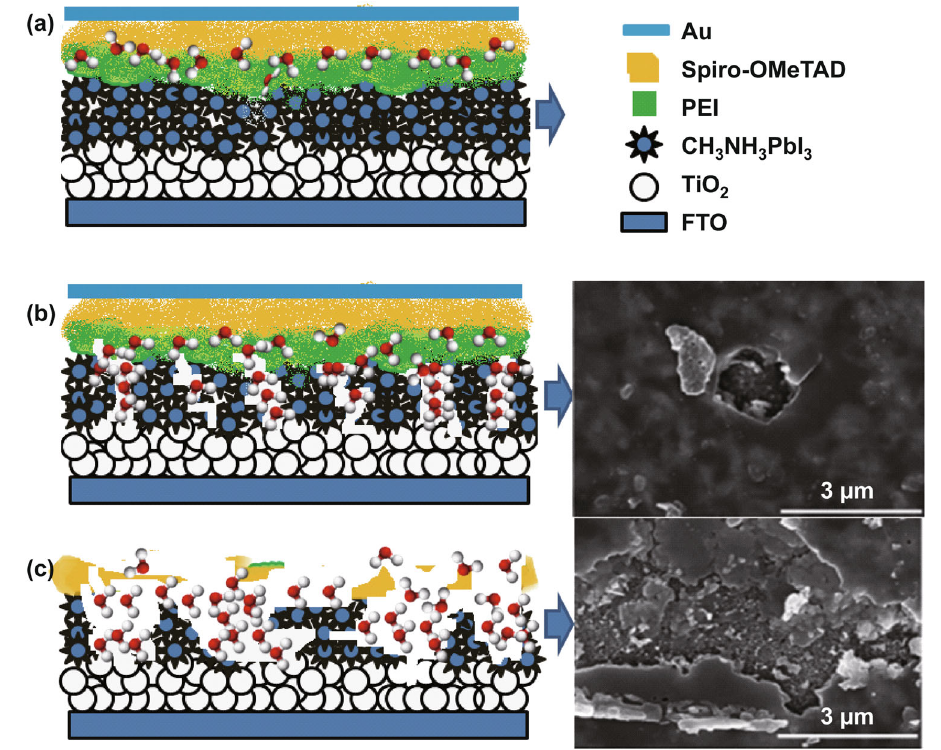
Fig. 19 Top view of the uncoated Au perovskite cell: a cell with PEI layer, b degradation of perovskite in the form of nanopinholes with PEI layer, and c degradation of cell randomly all over without PEI layer and corresponding SEM images. Reproduced with permission Ref. [196]. Copyright (cid:2) 2015 The Royal Society of